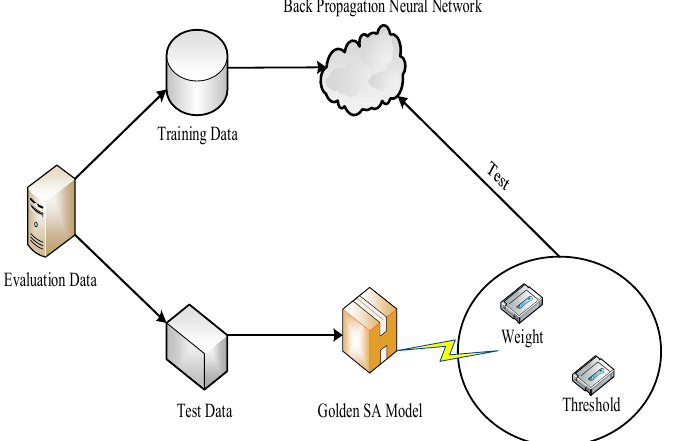
Figure 3. Teaching quality evaluation model architecture based on Gold-SA and BPNN model.